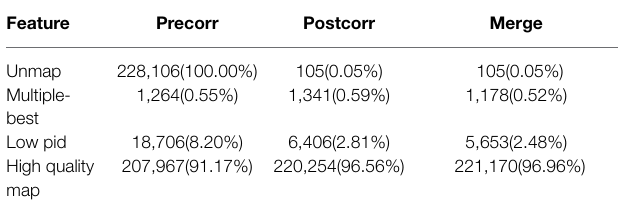
TABLE 1 | Classification of reference genome comparison results. Feature